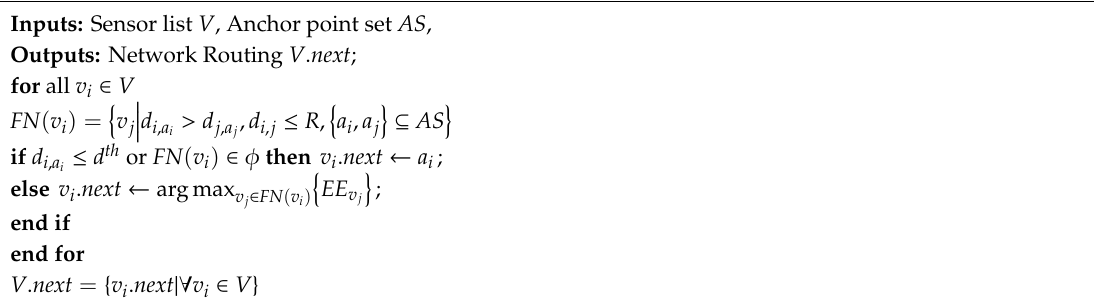
Algorithm 1: Adaptive dual-mode routing-based mobile data gathering algorithm.